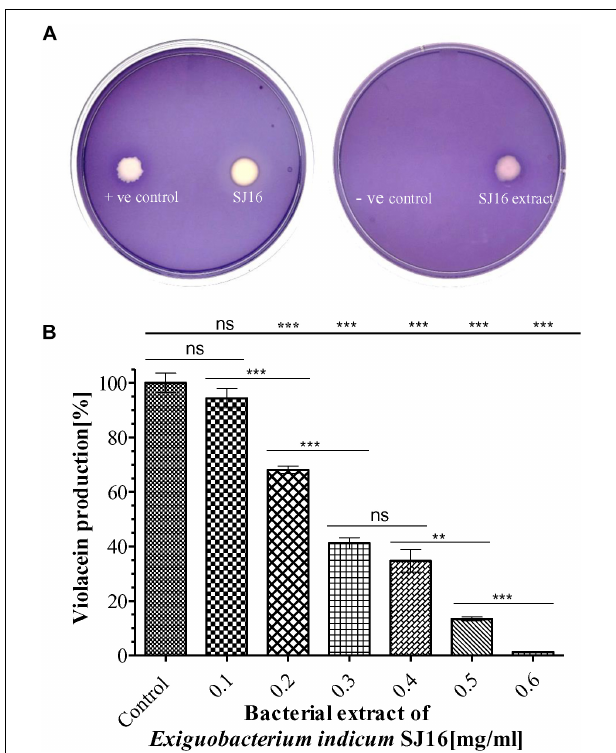
FIGURE 2 | Anti-quorum sensing activity of SJ16. (A) The biosensor plates containing the reference strain C. violaceum CV026 were spotted with cinnamaldehyde (positive control), SJ16 (axenic culture), SJ16 extract, and methanol (negative control). A bright white opaque zone of inhibition showed anti-QS activity. (B) Different concentrations of bacterial extract (0.1–0.6 mg/ml) were used to quantify the inhibition of violacein production, an indicator of QS activity. Culture without extract was considered as a control. “ ∗∗ ” and “ ∗∗∗ ” Indicates significant differences from the control at P < 0.01 and P < 0.001,